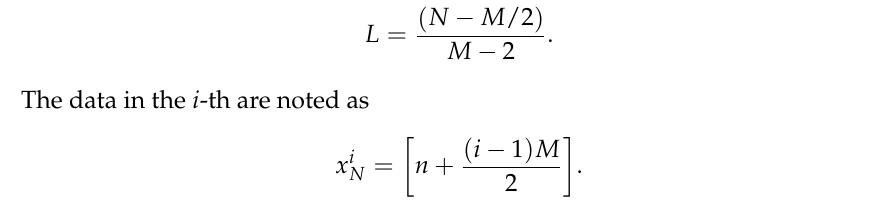
where U is the normalization factor.